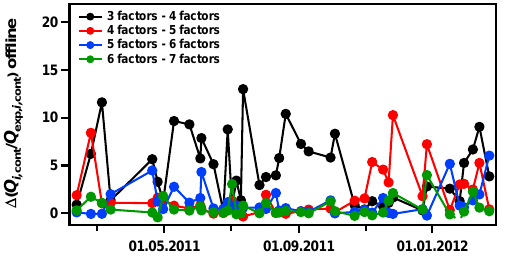
Figure 6. Change in the time-dependent contribution of Q/Q exp as a function of the number of factors (cid:49) (cid:0) Q i, cont /Q exp ,i, cont (cid:1) for a chosen offline solution (for a HOA = 0 . 0 and a COA = 0 . 0).